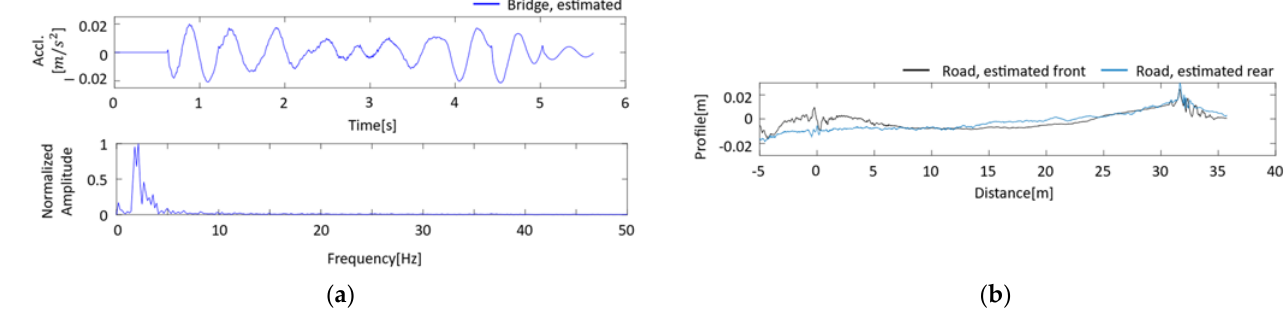
Figure 9. The VBISI method estimation result: ( a ) bridge vibration in time and domain; ( b ) road Figure profile.